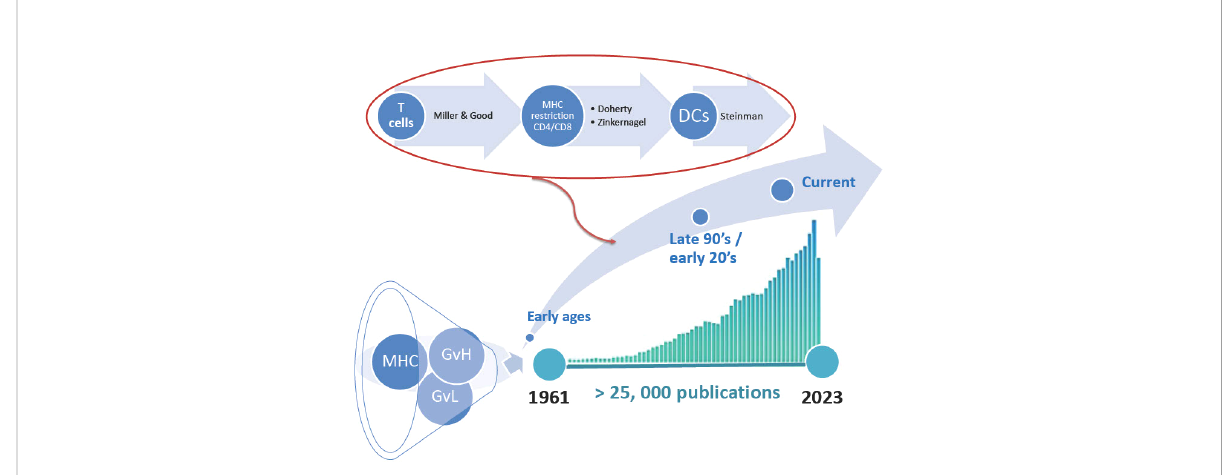
FIGURE 1 Referenced publications on graft-versus host disease (GVH). The diagram illustrates the number of publications referenced in PubMed as of October 2022. MHC, major histocompatibility complex; GvL, graft-versus-leukemia effect; DCs, Dendritic